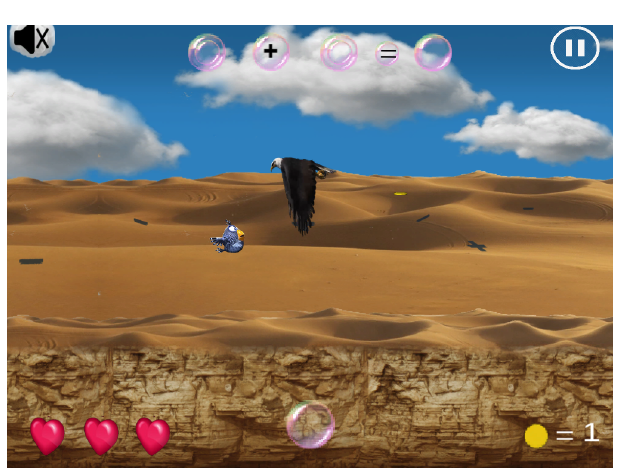
Figure 1. Screenshot of the first level of the